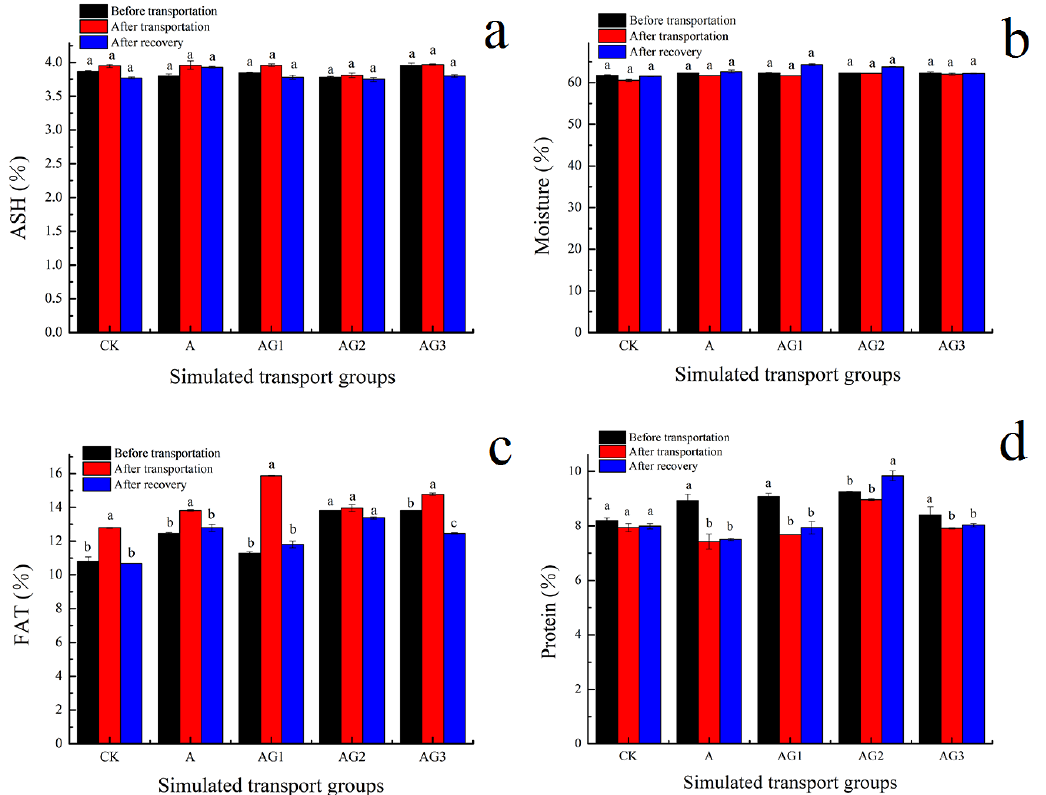
Figure 7. E ff ect of ascorbic acid and β -1,3-glucan addition on ash ( a ), moisture ( b ), fat ( c ) and protein ( d ) of muscle of tiger grouper during simulated transport. Among di ff erent treatments transport groups, di ff erent small letters indicate the results of Duncan’s test at di ff erent transport time. The same letters mean no significant di ff erence ( p > 0.05), while di ff erent letters mean significant di ff erence ( p < 0.05). Di ff erent letters without * = p -value < 0.05, di ff erent letters with ** = p -value <